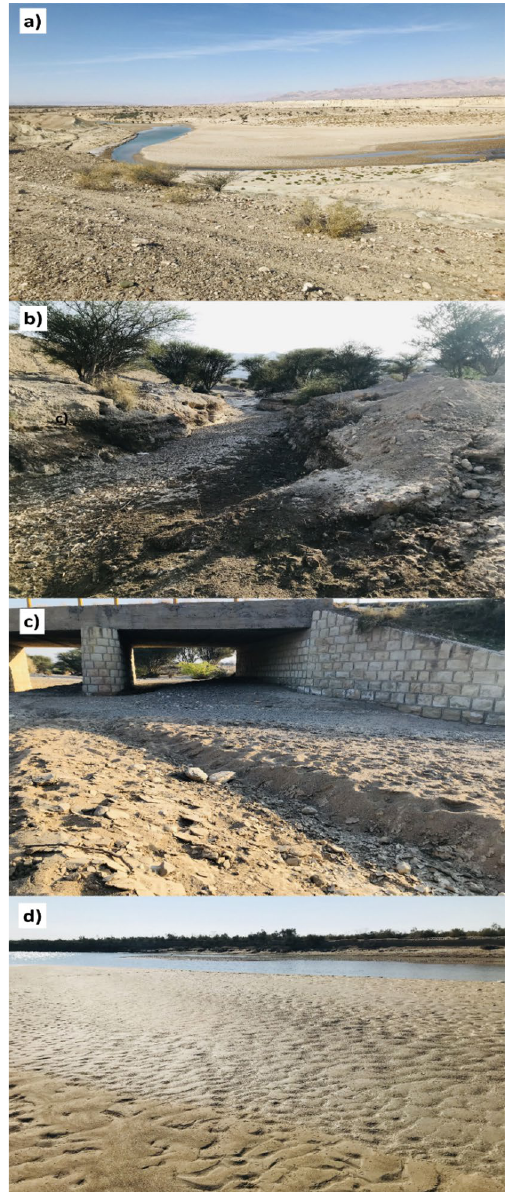
Figure 2. Photographs showing the sediment deposits where the samples were collected from: ( a ) western sub- basin; ( b ) central sub-basin; ( c ) eastern sub-basin, and; ( d ) the main channel of the Mehran River in the vicinity of the overall catchment